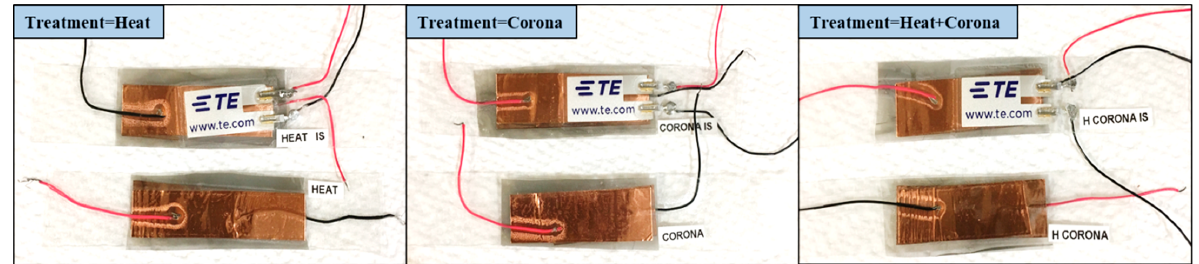
Figure 2. Images of the different fabricated sensors using the fabricated, plasma, and plasma-heat treated samples.